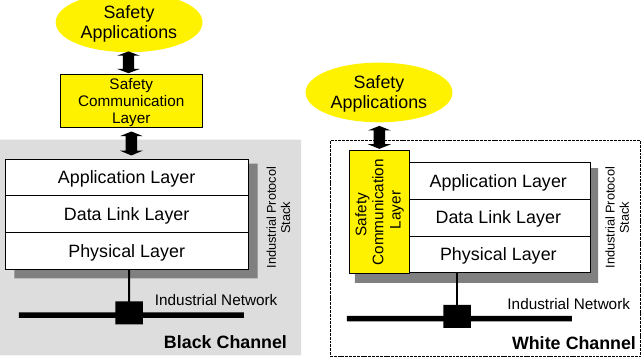
Figure 1. Functional Safety Protocols: Black and White Channel